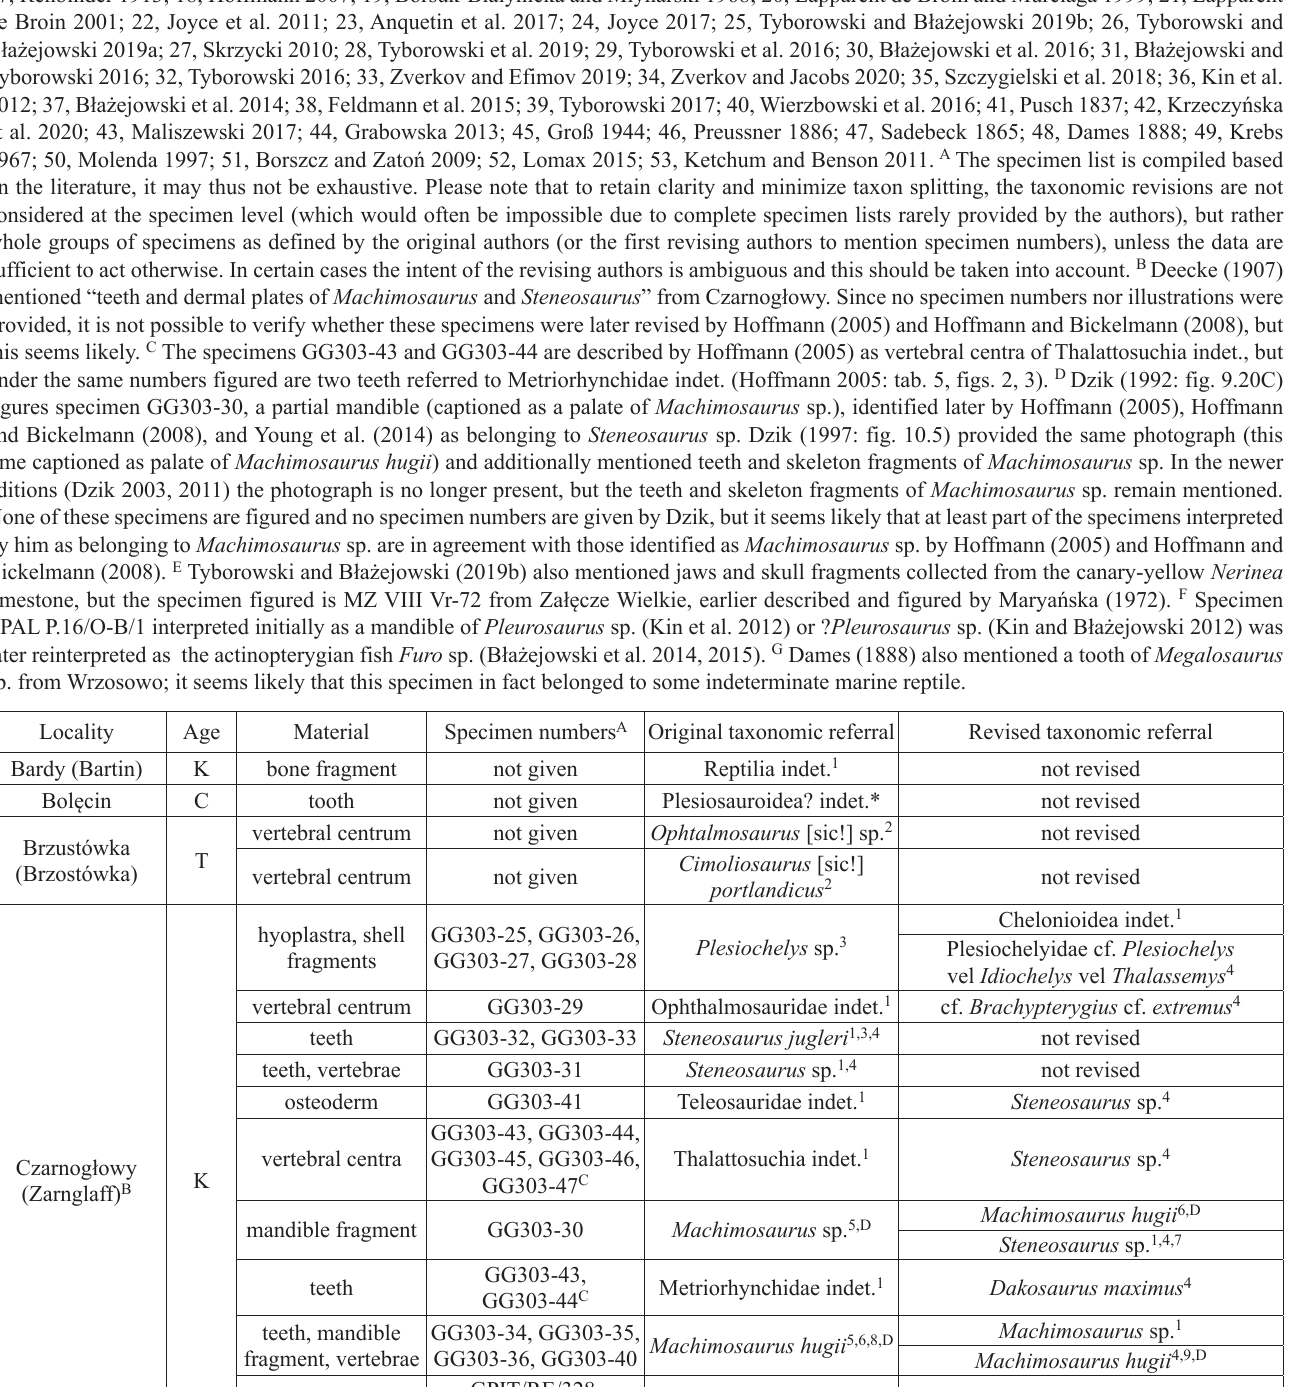
Table 1. Historical material of marine reptiles from the Jurassic of Poland. Abbreviations: A, Aalenian; B, Bathonian; C, Callovian; O, Oxfordian; K, Kimmeridgian; T, Tithonian; * Piotr Sterkowicz, personal communication 2020; ** unpublished; *** this study. References: 1, Hoffmann 2005; 2, Hirszberg 1924; 3, Deecke 1907; 4, Hoffmann and Bickelmann 2008; 5, Dzik 1992; 6, Dzik 1997; 7, Young et al. 2014; 8, Dzik 2003; 9,